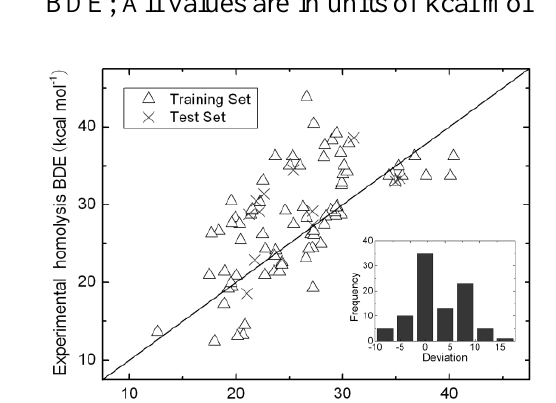
Figure 3. Calculated homolysis BDE versus experimental homolysis BDE for all 92 organic molecules; ( a ) B3LYP 6-31G (d) calculated homolysis BDE from the DFT approach; ( b ) full-descriptor GRNN corrected homolysis BDE for the F-GRNN approach; ( c ) The combined GRA and GRNN corrected homolysis BDE for the G-GRNN approach; ( d ) The combined GRA, PCA and GRNN corrected homolysis BDE for the GP-GRNN approach. Triangles (∆) are for the training set and crosses (×) are for the test set. Insets are the histograms for the differences between the experimental and calculated homolysis BDE; All values are in units of kcal mol − 1